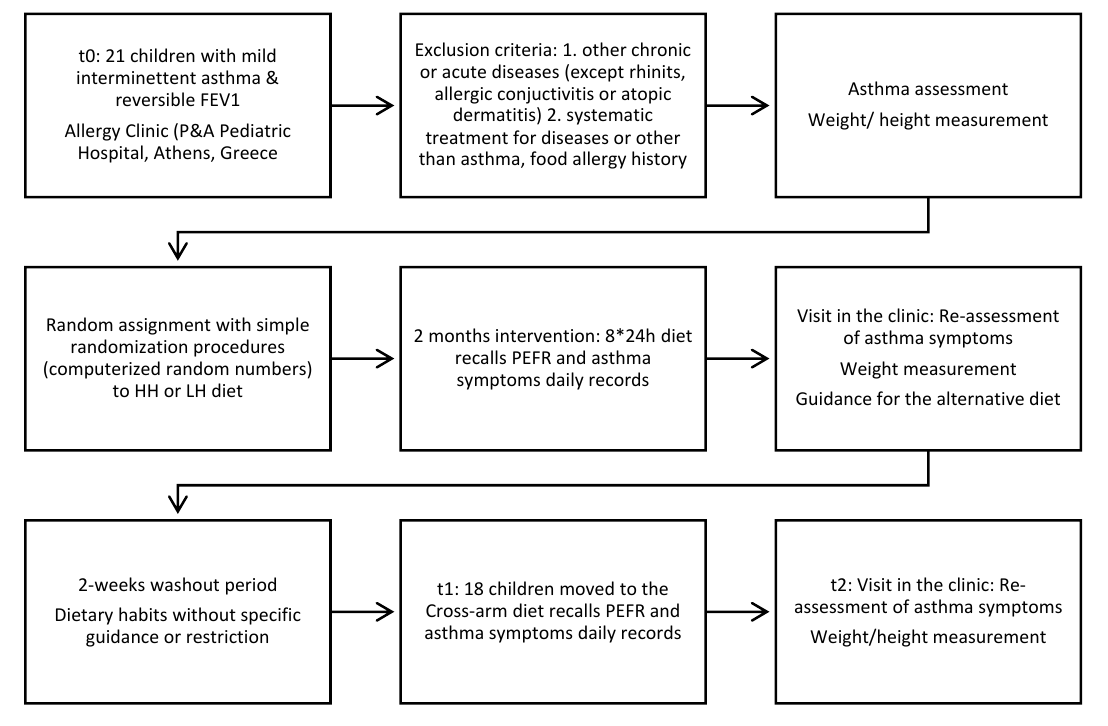
Figure 1. Participant flowchart.